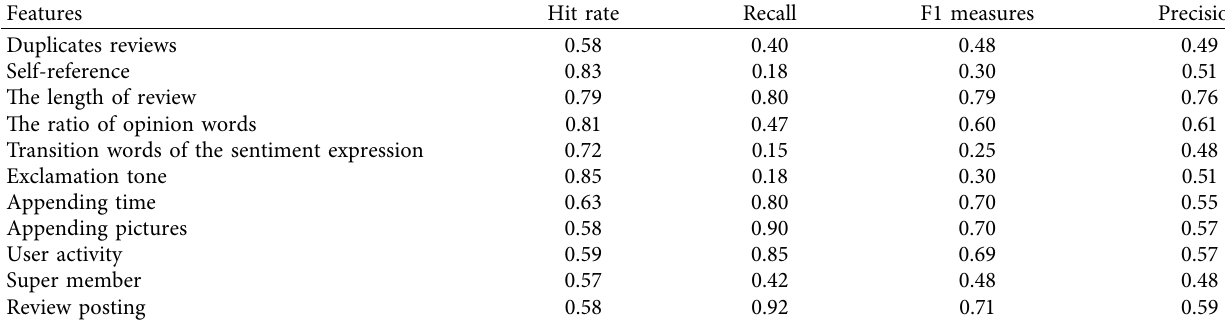
Table 4: Effect results for 11